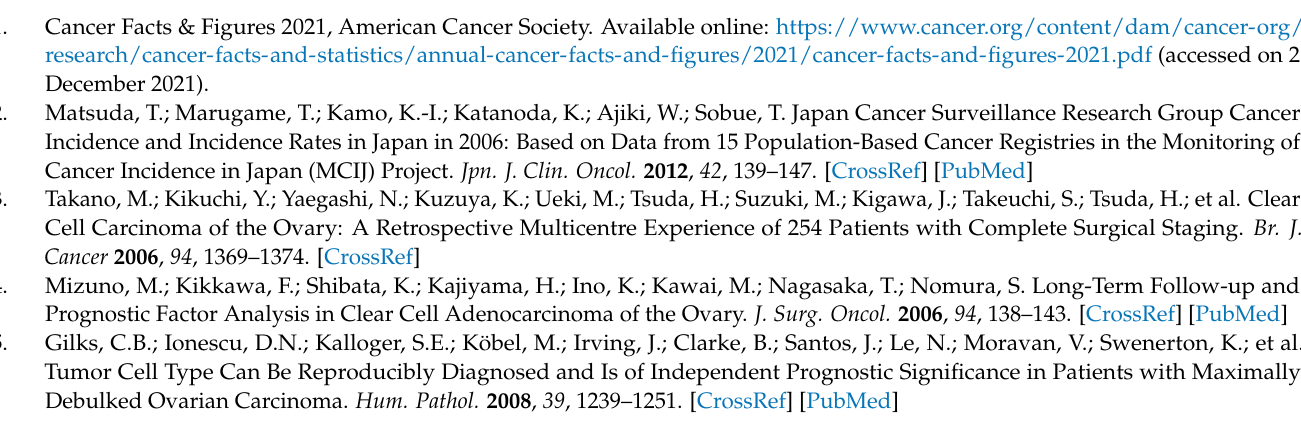
Figure S2: Quantification of transcription factor expression connected to KDM2A (Figure 2D); Table S1: Primers used for RT-qPCR; Dataset S1: A dataset containing the results obtained in each cell line analyzed by MAGeCK-MLE; Dataset S2: A dataset containing the results obtained in PIK3CA, ARID1A mutant cell lines (OVISE, TOV21G) and wild-type cell lines (ES2, JHOC5) analyzed by